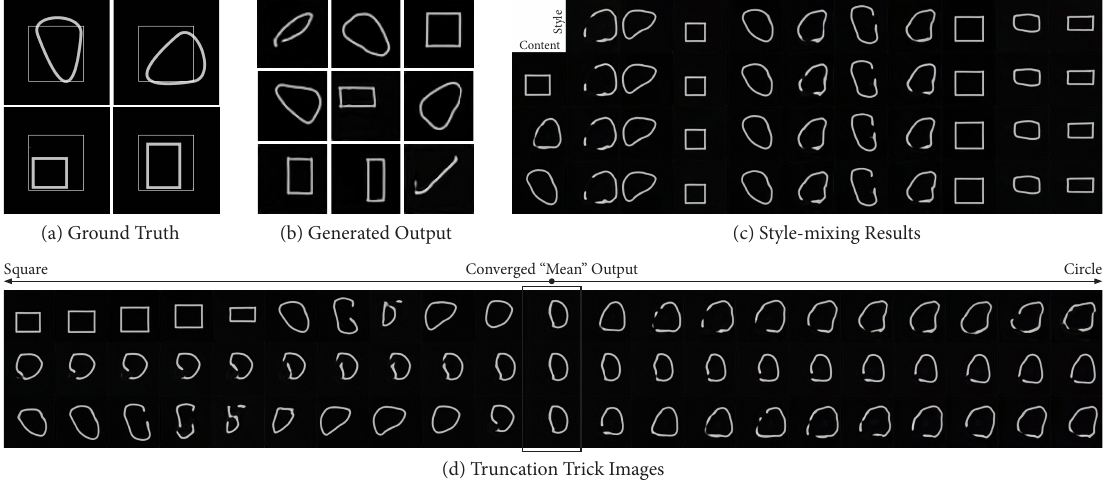
Figure 5. These are the training processes and results of designed circle and square drawings: ( a ) Example of input data. ( b ) Selected output fake images. ( c ) Contents, styles, and mixed results. ( d ) Continuing transforming images stack.